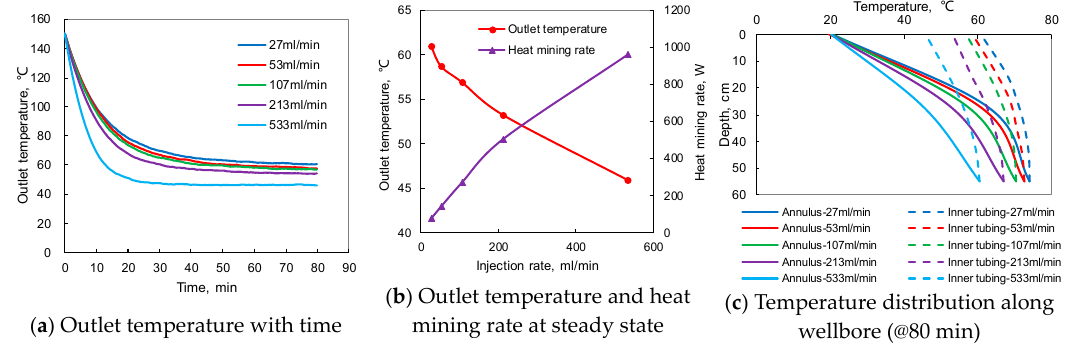
Figure 14. Temperatures at the outlet and along the wellbore at different injection rates.